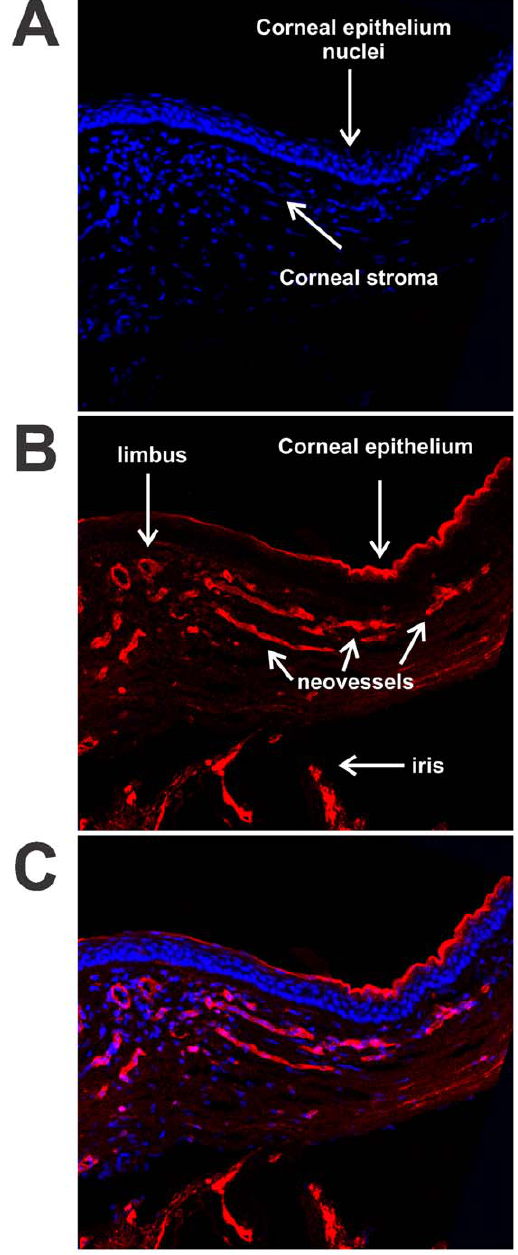
Figure 5. Localization of corneal neovessels with isolectin IB 4 . Cryosections of temporal corneas were prepared 14 days after implantation with a 20% 7KCh wafer. The sections were labeled with AlexaFluor 568 Isolectin IB 4 (red) and the nuclei stained with DAPI (blue). A. DAPI stained section demonstrating the location of the corneal stroma and epithelium. B. Isolectin IB 4 labeling of neovessels, corneal epithelium and iris. C. Combined image. Arrows mark the different